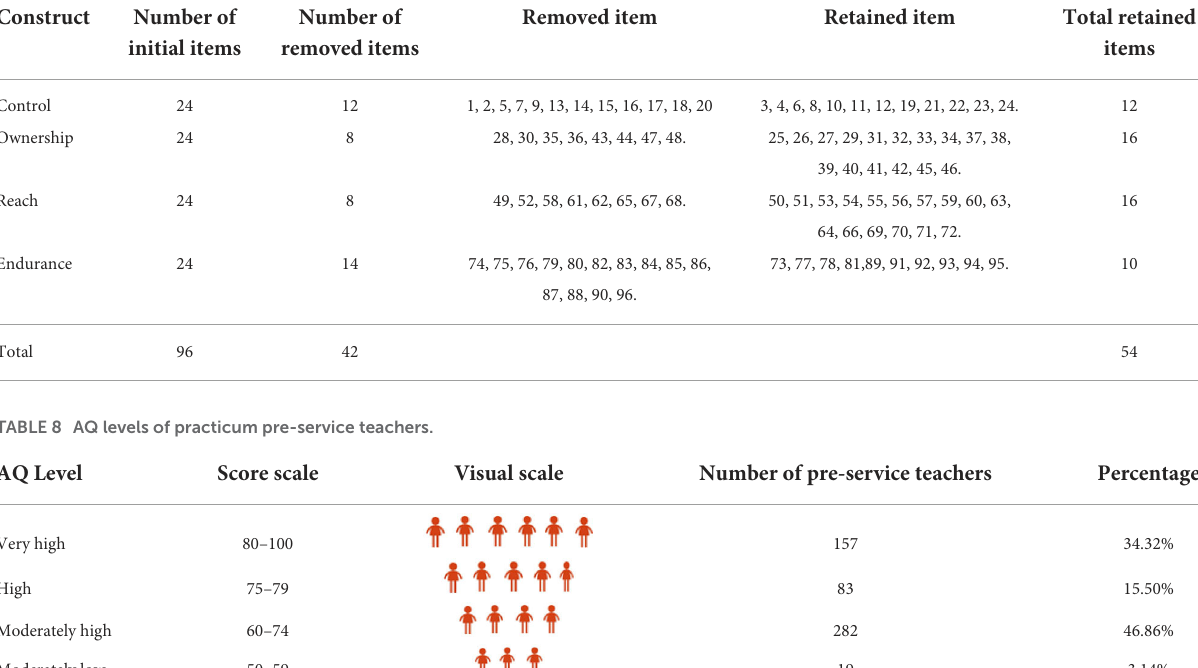
TABLE 7 Summary of removed and retained items.